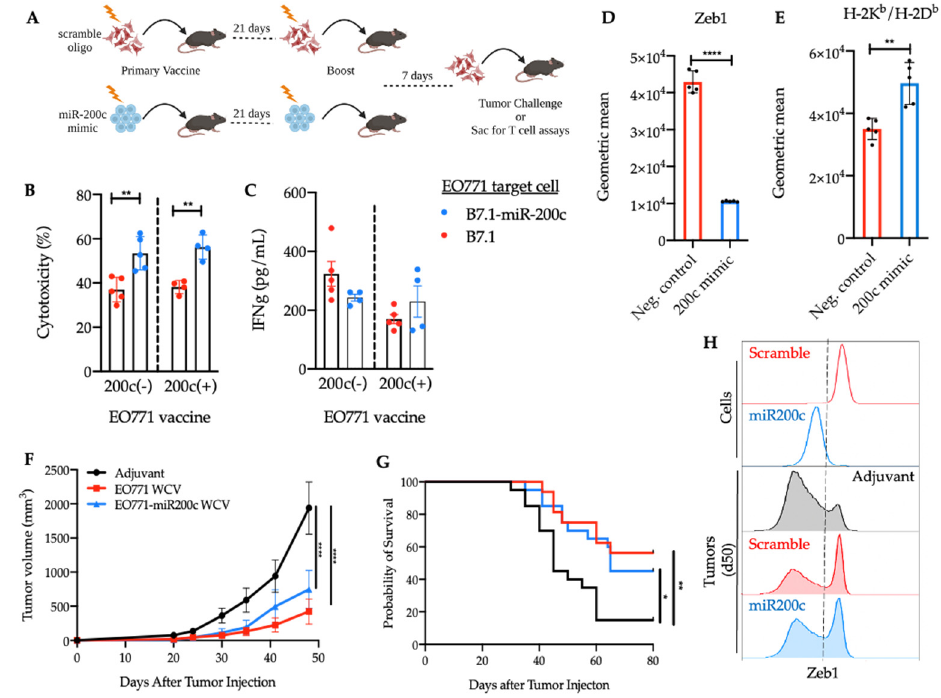
Figure 3. Following miR-200c restoration, enhanced cytotoxicity against EO771 target cells is asso- ciated with MHC class I expression. ( A ) Overview of study design. ( B ) Quantification of percent cytotoxicity and ( C ) IFN γ measurements from splenocytes of mice against EO771-B7.1 ± miR-200c target cells following vaccination with EO771 WCV ± miR-200c. Cells were co-cultured at E:T ratio of 20:1. Target cells are shown in the figure legend. A two-way ANOVA was performed using Sidak’s multiple comparisons test, finding a significant increase in cytotoxicity against EO771-B7.1-miR-200c+ target cells in both the EO771 WCV ( p = 0.001) and EO771-miR-200c WCV ( p = 0.0012) groups. Data are representative of three independent experiments and are shown as mean ± SD. ( D ) Quantification of geometric mean of Zeb1 ( n = 5) and ( E ) MHC class I ( n = 5) on EO771 cells transfected with miR-200c for 72 h by flow cytometric analysis is shown. An unpaired t test shows a significant difference in Zeb1 expression ( p < 0.0001) and MHC class I expression ( p < 0.024) following miR-200c transfection. Data are representative of three independent experiments and are shown as mean ± SD. ( F ) Tumor growth curve of EO771 (mesenchymal-like) cells in mice treated with adjuvant only ( n = 20), EO771 WCV (mesenchymal-like) ( n = 16) or EO771-miR-200c treated WCV (epithelial-like) ( n = 20). Error bars depict mean with SEM. A two-way ANOVA was performed using Tukey’s multiple comparisons test and significant protection was provided by the EO771 WCV ( p < 0.0001) and EO771-miR-200c WCV ( p < 0.0001). ( G ) Survival curve of the same mice as in f; log rank (Mantel-Cox) test =0.0035. ( H ) Representative histograms of change in Zeb1 expression in EO771 tumors at day 50 in mice that received adjuvant, EO771 WCV, or EO771-miR-200c vaccine relative to baseline Zeb1 expression in EO771 cells ± miR-200c. The numerical p values listed in the figure legend correlate with the asterisks in the figure.